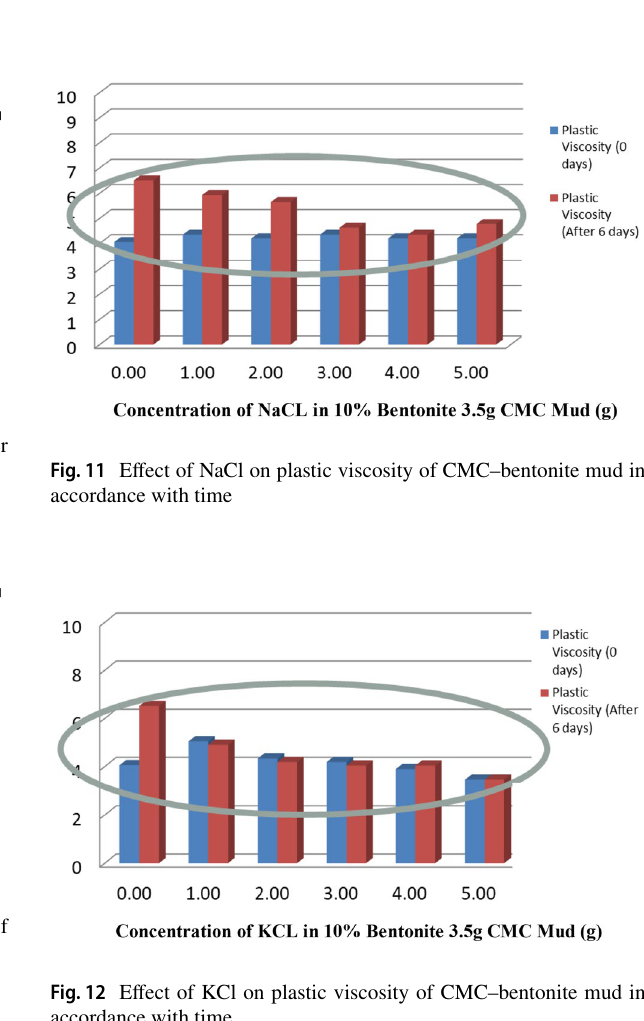
Fig. 7 Effect of NaCl, KCl and haematite on gel strength (initial) of CMC–bentonite mud